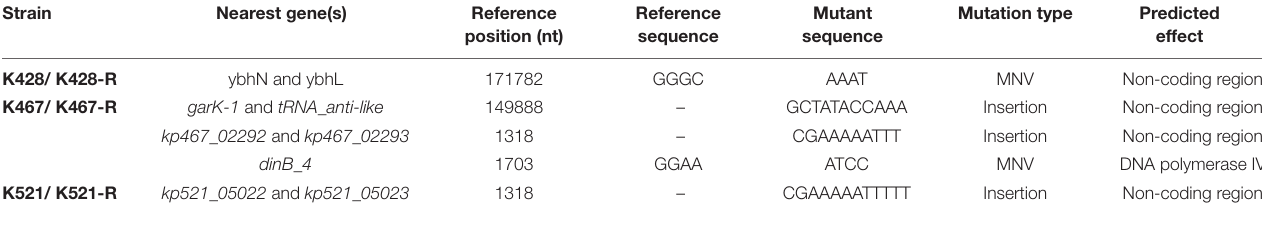
TABLE 3 | Mutations observed in the four clinical isolates and their resistance-induced descendant strains.